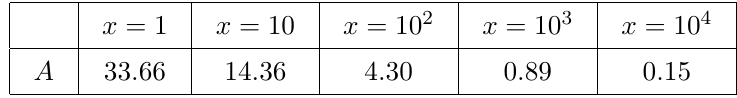
Table 2. Approximated values of A for different ratios of messenger